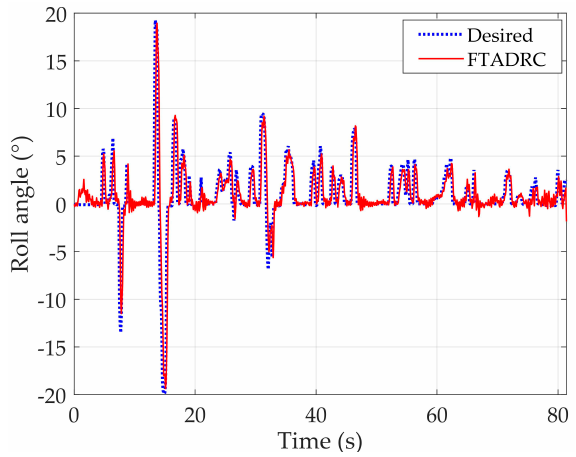
Figure 20 . Curves of roll angle. Figure 20. Curves of roll angle.